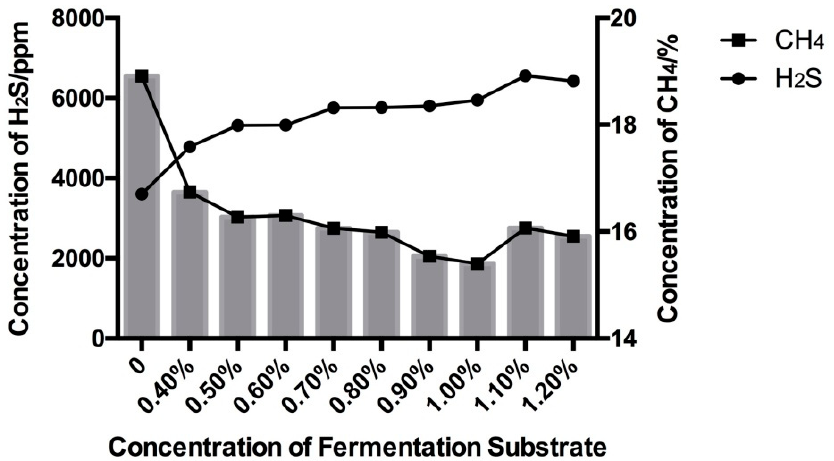
Figure 2. Gas content of in vitro fermentation of substrate with different levels of sulfate.